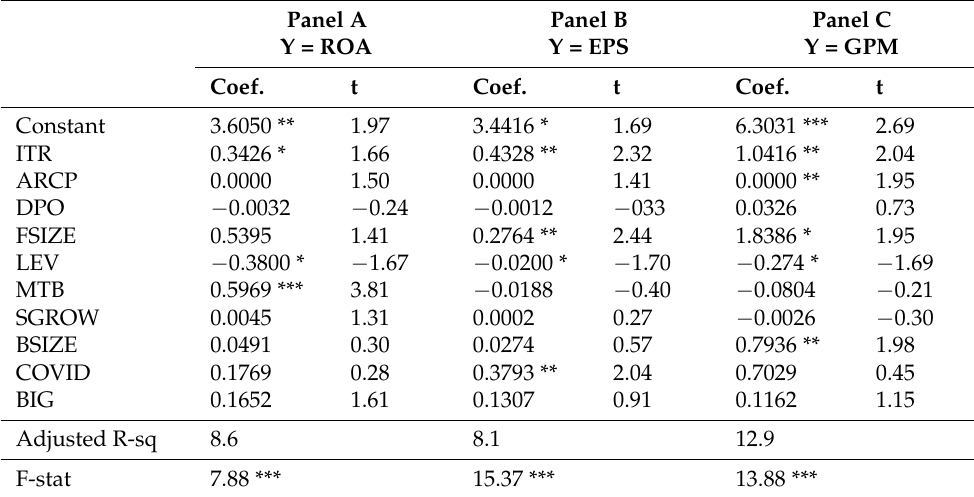
Table 4. Empirical